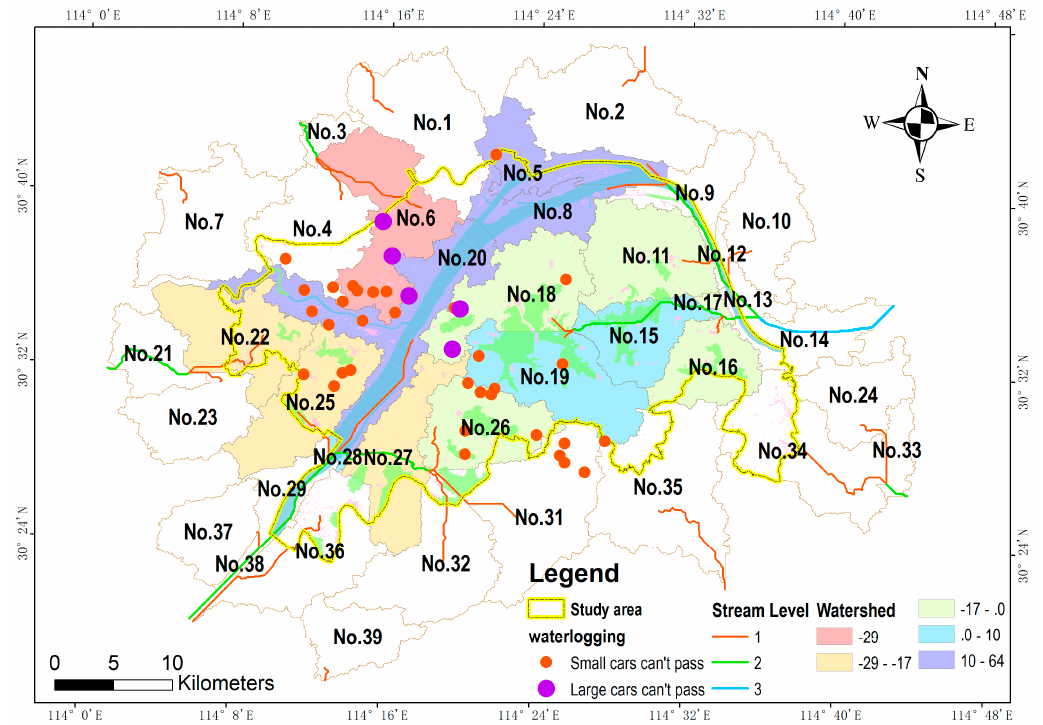
Figure 7. The waterlogging and carrying capacity in the flooding event in July 2016, showing the waterlogging sites overlapping with the estimated surplus storage of runoff rainwater.